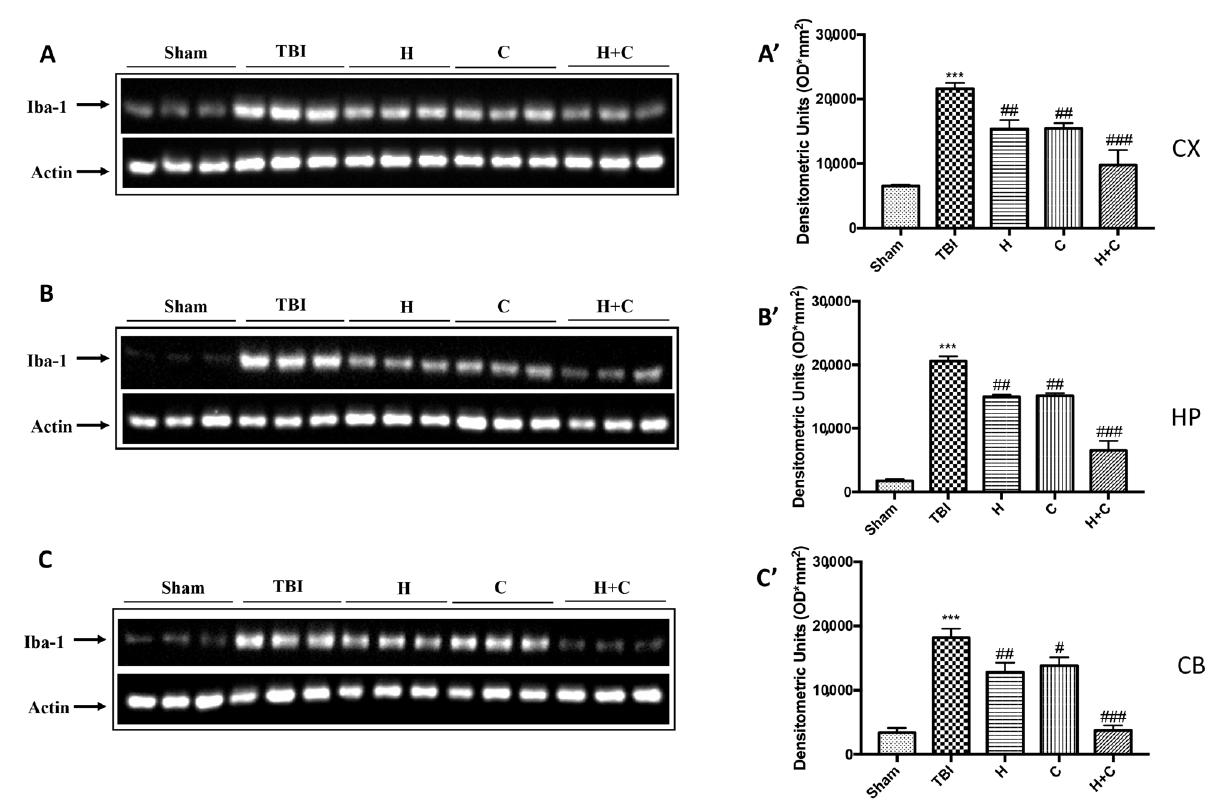
Figure 5. Effect of H. erinaceus or C. versicolor , or H. erinaceus + C. versicolor treatment on Iba-1 protein after chronic TBI. Western blot analysis showed that the expression of Iba-1 increased insignificantly in the TBI group in CX ( A ), HP ( B ) and CB ( C ) regions. H, C, and H + C treatment further significantly decreased the expression of Iba-1 ( A – C ). The data are expressed as the mean SEM from n = 5 mice/group. Densitometry analysis: ( A’ ) *** p < 0.001 vs. Sham; ## p < 0.01 vs. TBI; ### p < 0.001 vs. TBI; ( B’ ) *** p < 0.001 vs. Sham; ## p < 0.01 vs. TBI; ### p < 0.001 vs. TBI; ( C’ ) *** p < 0.001 vs. Sham; ## p <